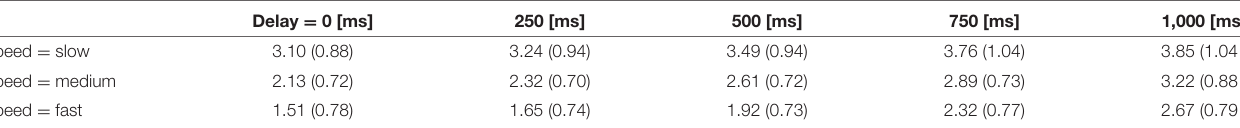
TABLE 1 | Average (standard deviation) of heaviness rating